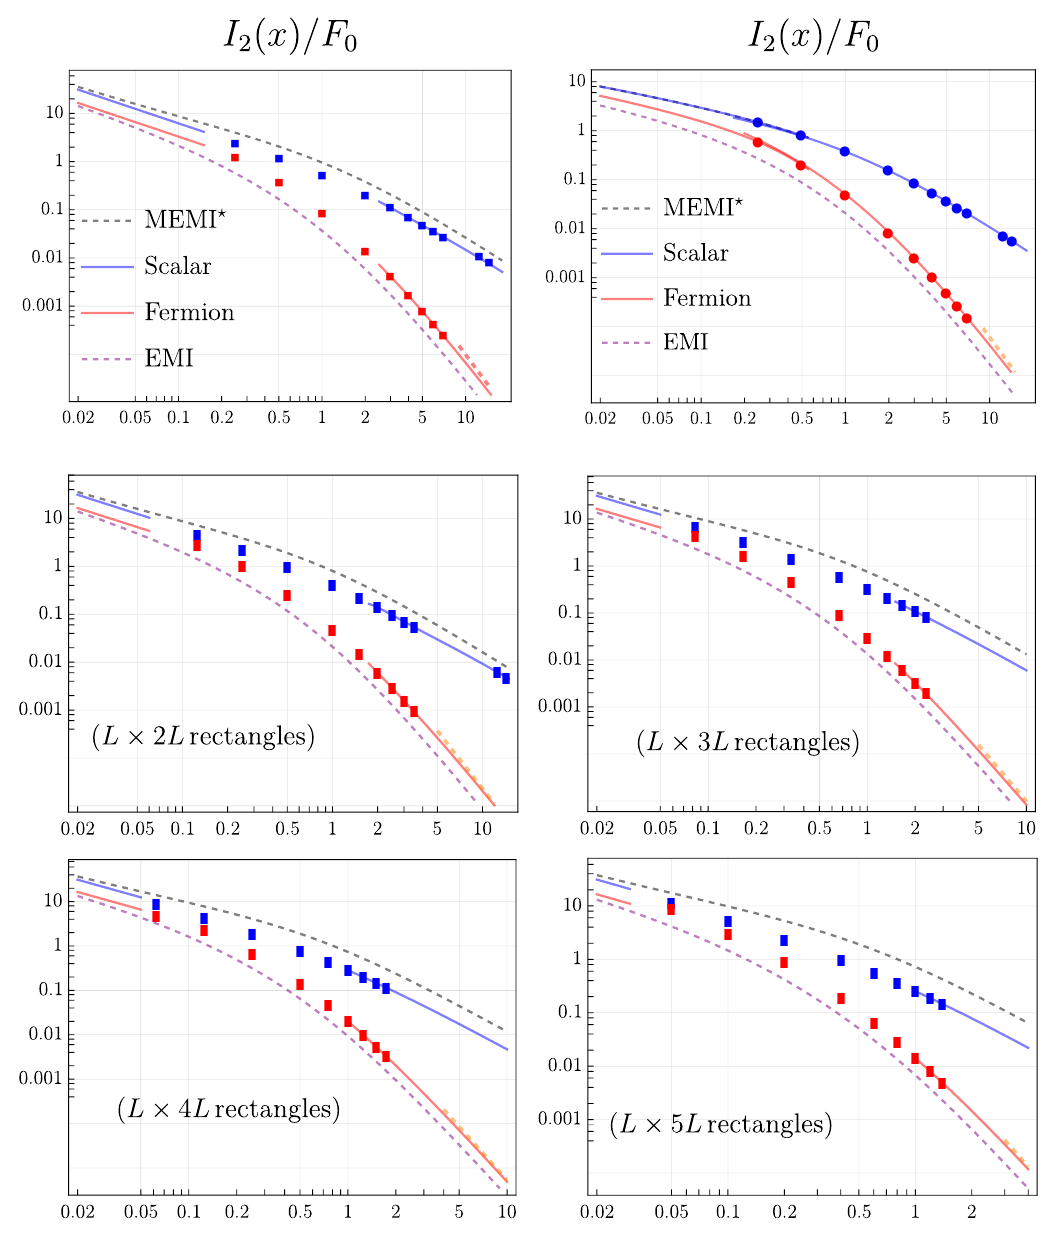
Figure 12 . We plot, in a log - log scale, the mutual information (normalized by the disk EE coefficient F 0 ) for pairs of identical regions for free scalars (blue), free fermions (red) and the analytic toy models EMI and MEMI ? (gray and purple, respectively) as a function of the dimensionless separation x ≡ r/R , ( R ≡ ξL ). The upper plots correspond to square (left) and disk (right) regions, respectively, whereas the middle and lower plots correspond to rectangle regions of sides L × (2 , 3 , 4 , 5) L . The thick blue and red lines represent the analytic approximations explained in the main text. The orange dotted lines correspond to the leading long-distance approximations obtained for the free fermion in